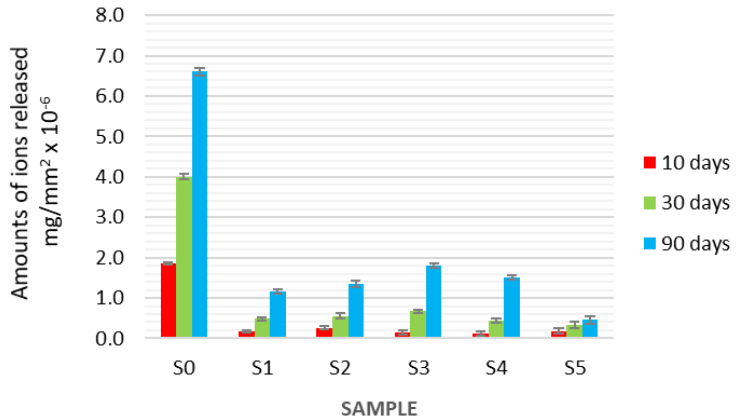
Figure 6. Amounts of Cr ions released into 0.9% solution NaCl for the particular coatings after 10, 30, and 90 days.